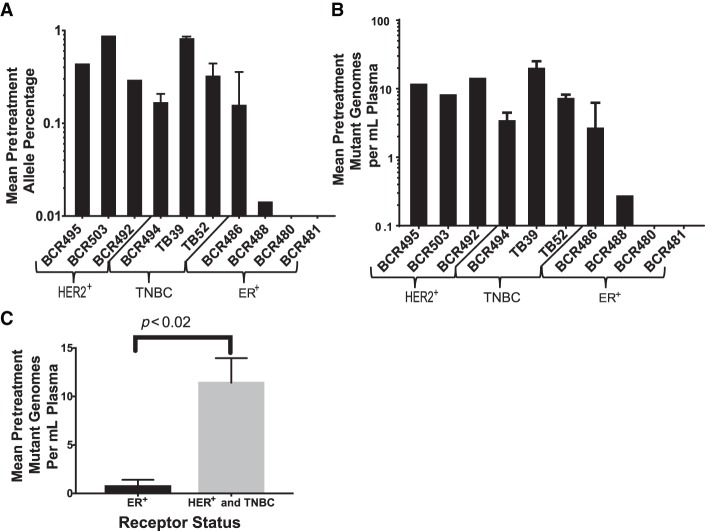
Pretreatment ctDNA levels. (A) Mean pretreatment ctDNA mutant allele percentage for 10 enrolled patients. Error bars ± SEM. (B) Mean pretreatment mutant genomes per mL of plasma for 10 enrolled patients. Error bars ± SEM. (C) Mutant genomes per mL of plasma grouped by receptor status ER+ HER– (4) versus all other statuses (ER+ HER2+ [2], ER– HER2+ [1], TNBC [3]). Error bars ± SEM, unpaired Student's t-test.